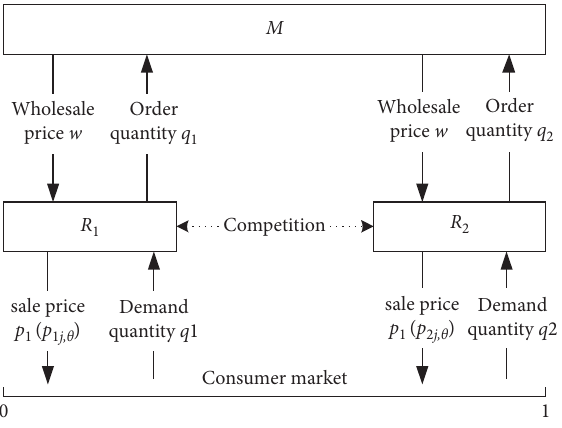
Figure 1: The supply chain